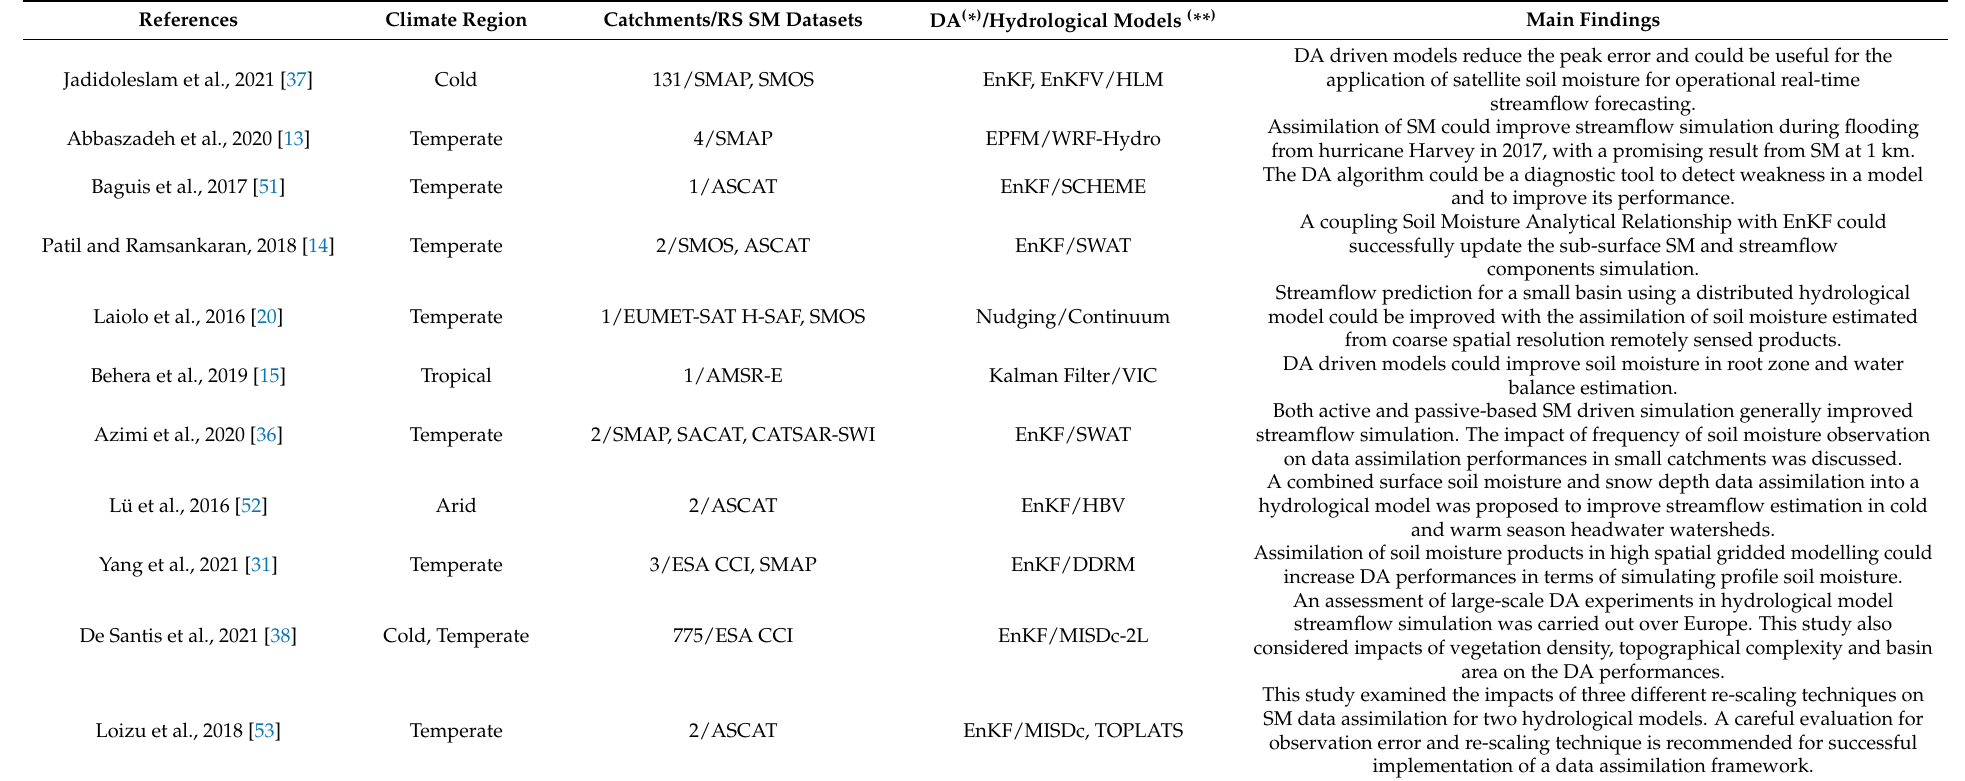
Table 1. Summary of selected studies on remote sensing soil moisture data assimilation in hydrologic models. These studies were investigated in terms of climate region, number of studied catchments, used remotely sensed (RS) soil moisture (SM) datasets, data assimilation (DA) technique with hydrologic models. More details on recent studies (2015-present) can be found in Supplementary Material Figure